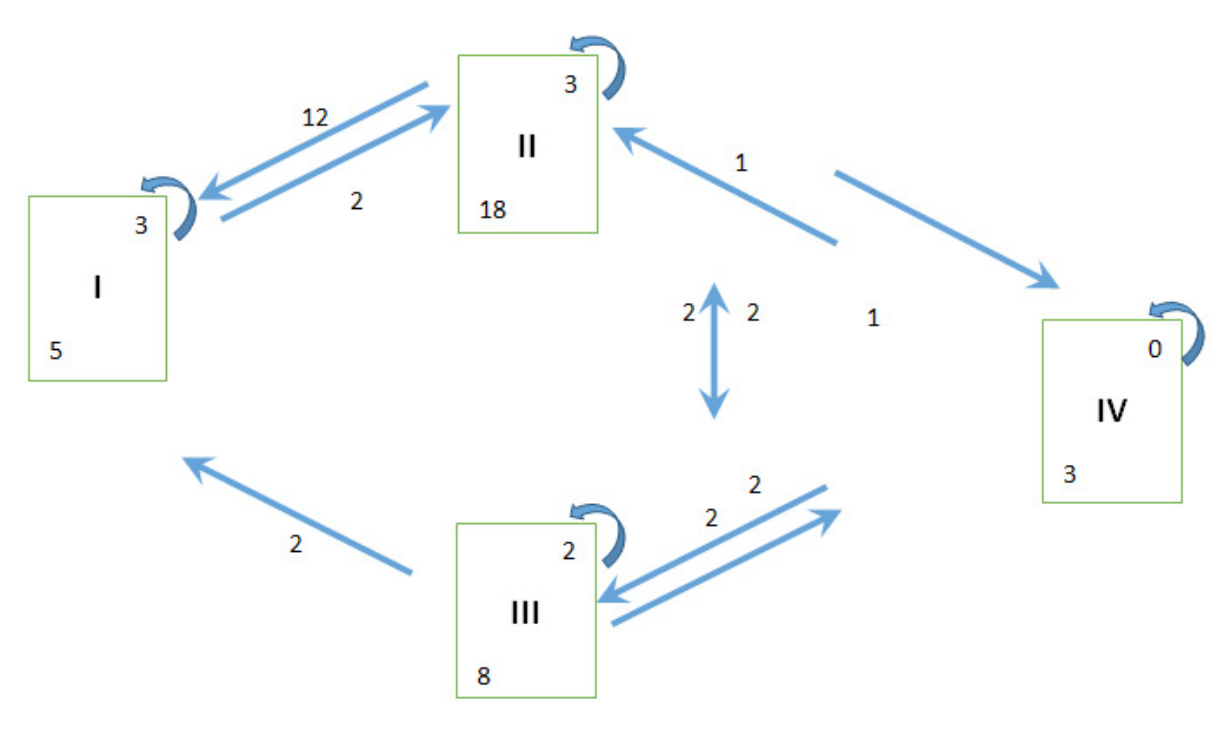
Fig 2 – Evolution of the pre and post-operative functional